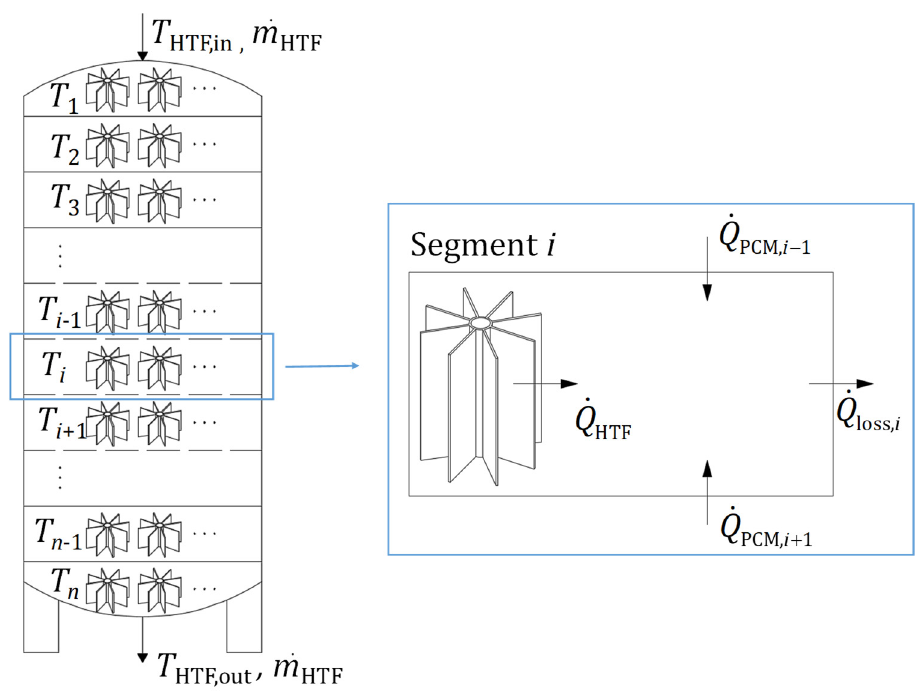
Figure 3. Schematic representation of a one-dimensional computational model of shell and finned tube LTES and the i th segment.